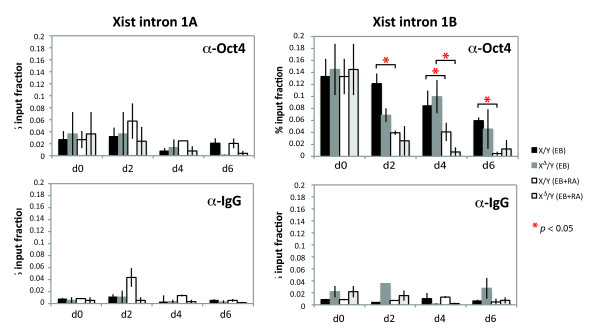
Oct4-binding to Xist intron 1 decreases faster when differentiated in the presence of RA. Quantitative ChIP analyses of Oct4-binding to Xist intron 1 show faster reductions in Oct4-binding kinetics when wild-type and Tsix-deficient male cells were differentiated by EB+RA versus EB methods. Note that, for each experiment, we started with a single d0 (undifferentiated) culture for both X/Y and XΔ/Y, and then split them on subsequent days for analysis. Thus, d0 samples were the same for all EB series and for all EB+RA series, and their values were duplicated in the graphs for easier comparisons with d2, d4, d6 samples in the same series. Means ± s.e.m from two independent biological replicates are shown. Pairwise comparisons were made between corresponding samples (EB vs. EB+RA) normalized to the control IgG ChIP (background) for each time point. Statistical significance of each result was calculated using paired, two-tailed Student's t-tests. * p < 0.05.